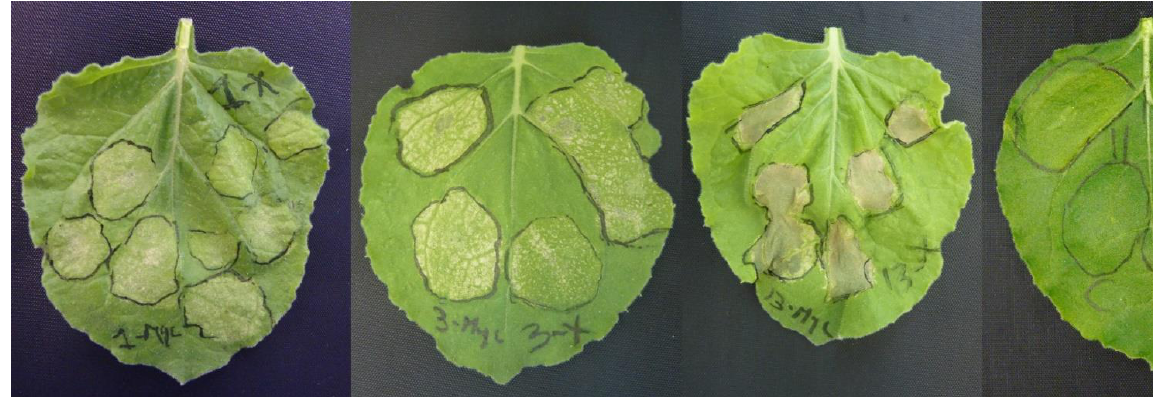
Figure 7. Transient expression of M. fructicola candidate effector genes inducing cell death in N. benthamiana . From left to right: MFRU_002g05260, MFRU_030g00580, MfNep2 and empty-vector control. The left leaf halves were infiltrated with a construct carrying a Myc-tagged effector coding sequence, while right leaf halves were infiltrated with untagged constructs. Constructs of candidate effector genes MFRU_012g01440, MFRU_034g00500 and MFRU_048g00370 looked similar